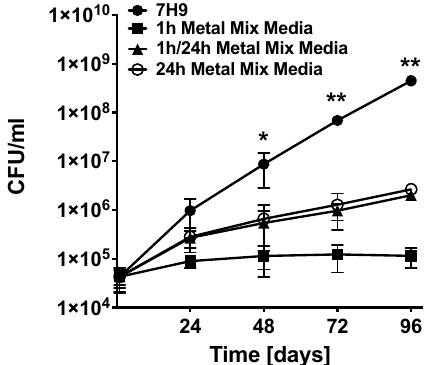
Figure 2. MAH104 growth dynamics in 7H9 broth culture and metal mix. The viable MAH104 colony forming units were recorded in 7H9 culture media or in vitro phagosome model of 1 h, 1 h/24 h or 24 h metal mix. Bacteria were cultured in the corresponding media at time zero and growth kinetics were monitored over 4 days. Data represent the means ± standard deviations (SD) obtained from four independent experiments performed in triplicates. Unpaired two tailed t -test was performed. * p < 0.05 and ** p < 0.01 statistical significance between the experimental (all metal mix) and control groups.